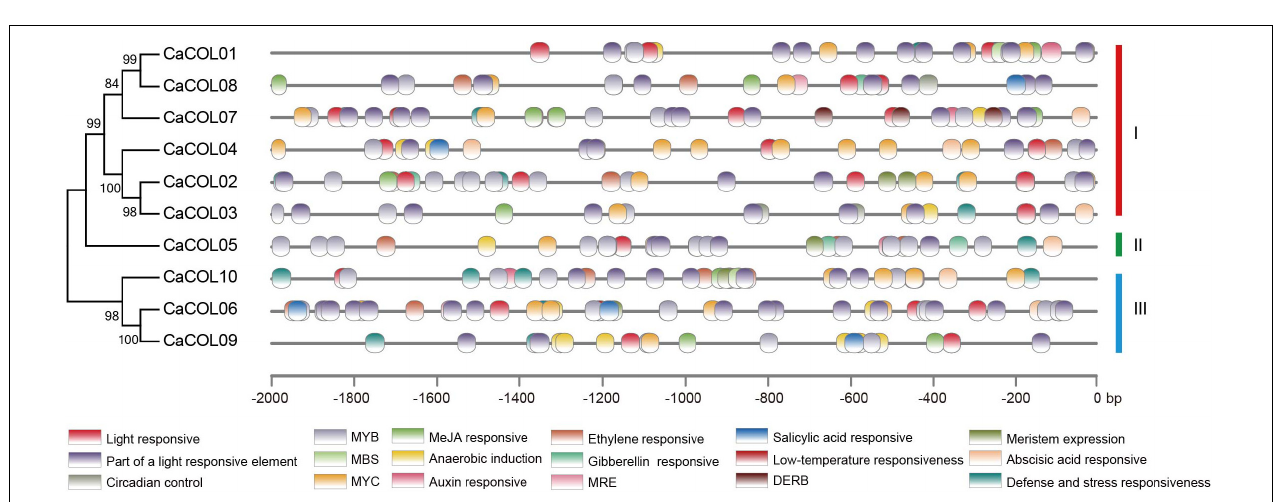
FIGURE 3 | Predicted cis -elements in the promoter regions of CaCOL genes. Promoter sequences (-2000 bp) of CaCOL genes were analyzed. The elements are identified as different colored boxes.